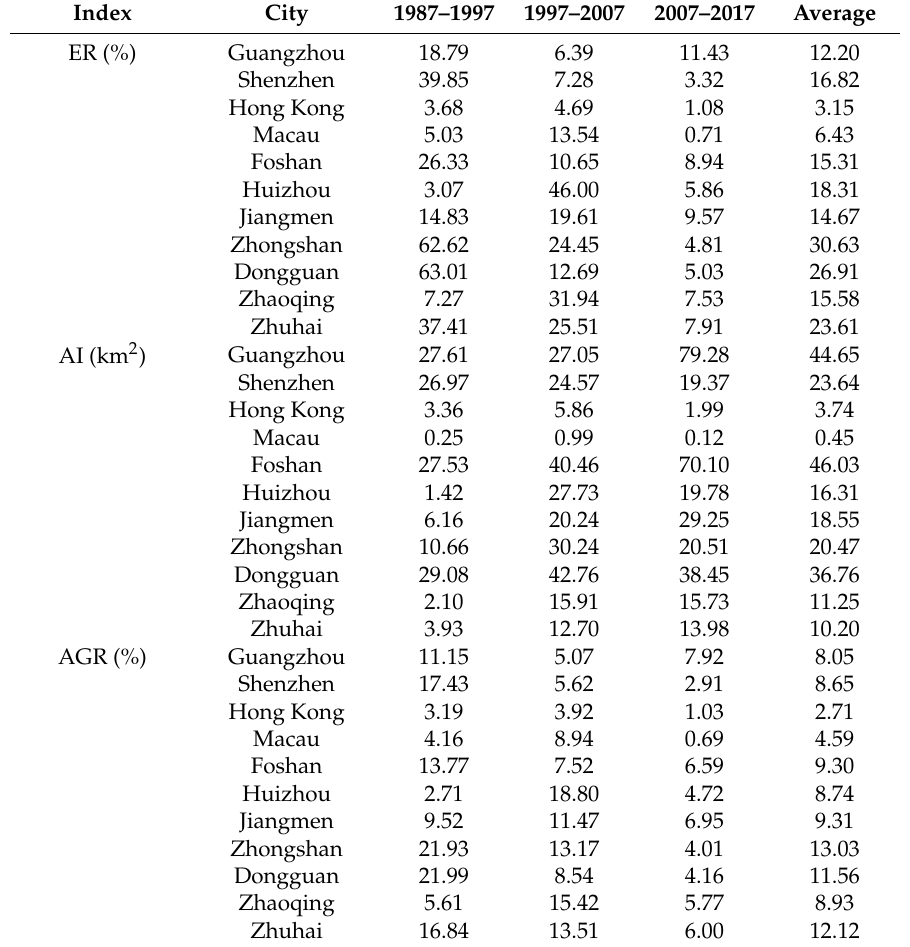
Table 6. Annual increase (AI), expansion rate (ER, %), and annual growth rate (AGR, %) for 11 cities in the GBA for three neighboring periods in